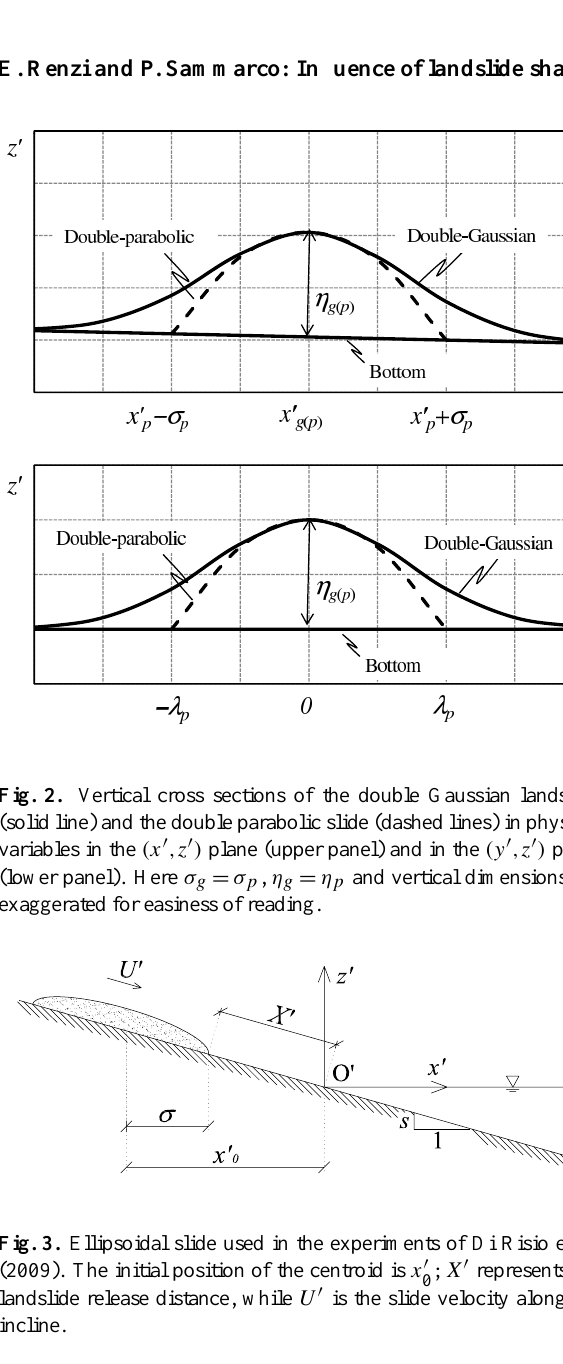
; X 0 represents the 0